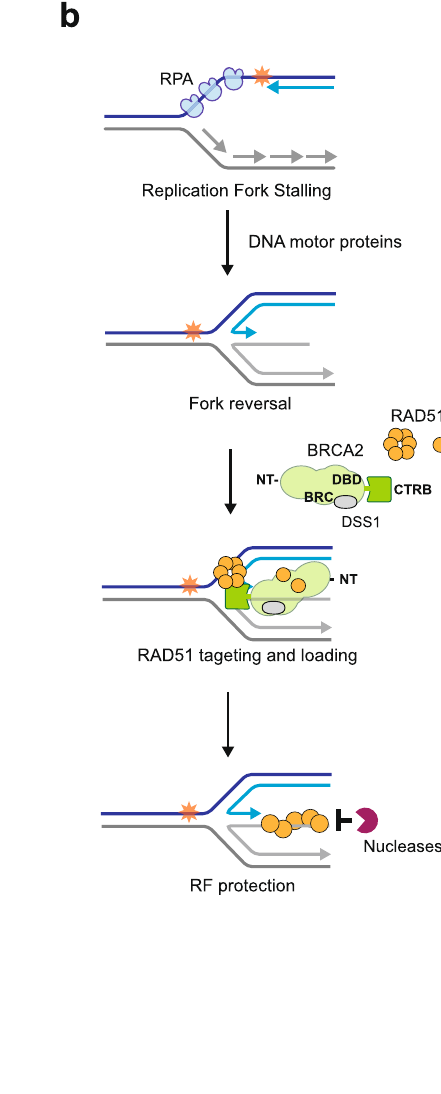
0.3046; betweenthe F/Agroup and the F/A: HU+Mirin group is0.09772;between the 4A group and the 4A:HU+Mirin group is 4.396×10 − 2 ; between the F/A_4A group and F/A_4A:HU+Mirin group is 0.04908.) Representative micrographs of DNA fi bers (EV: empty vector. WT BRCA2 cells) from Supplementary Fig. 5 are shown.SourcedataareprovidedasaSourceData fi le. b ModelforCTRBfunctionat regressed replication forks. Through its interaction with oligomeric RAD51 and DNAengagement,theCTRBhelpsseedtheassemblyofaRAD51protein fi lamentof the arm of a regressed replication fork that harbors the free DNA